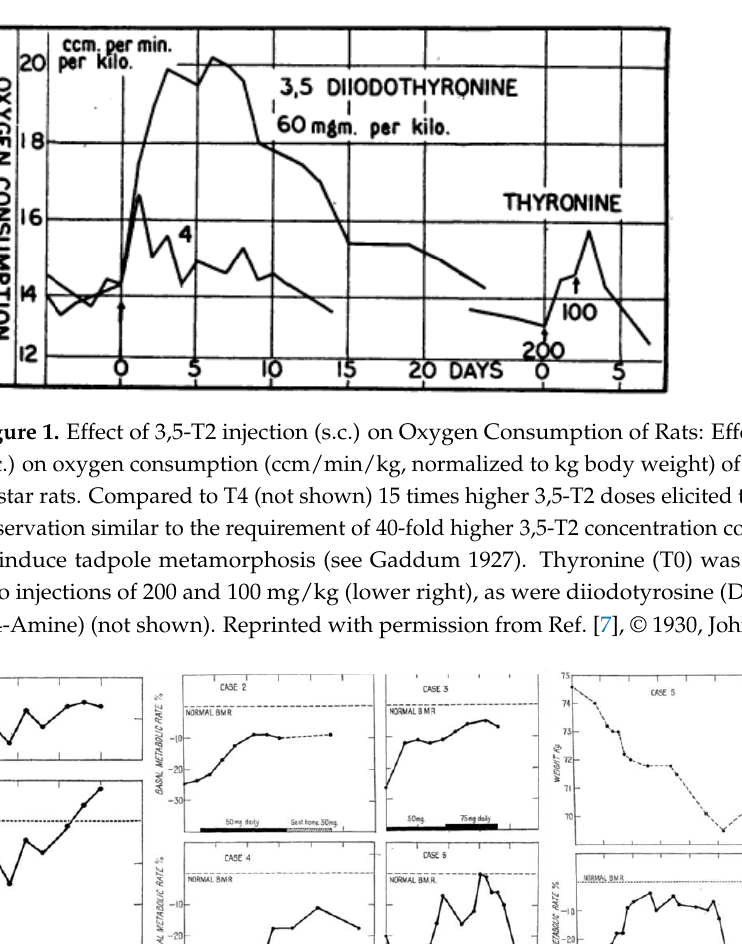
with modest activities (7–11 % vs. T4), tested in that series that lacked substituents at the phenolic